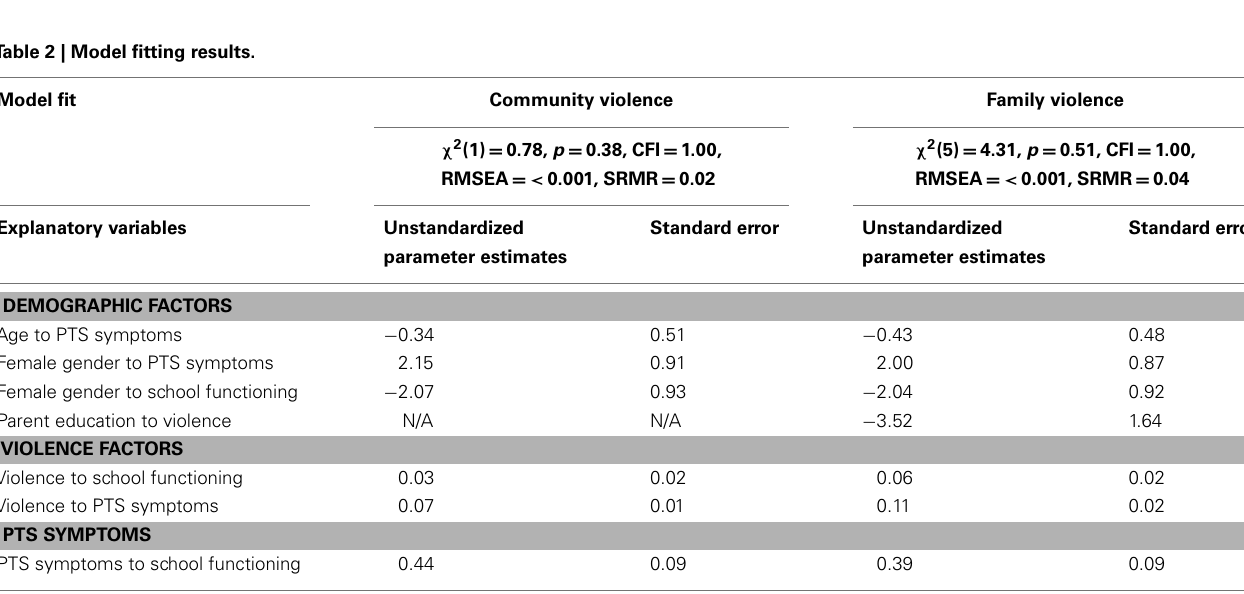
Table 2 | Model fitting